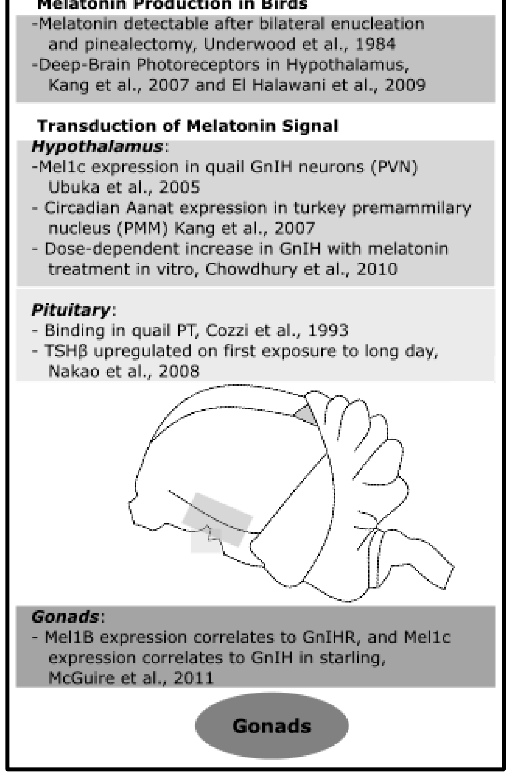
Figure 6. Summary of major findings on melatonin in the avian HPG axis.